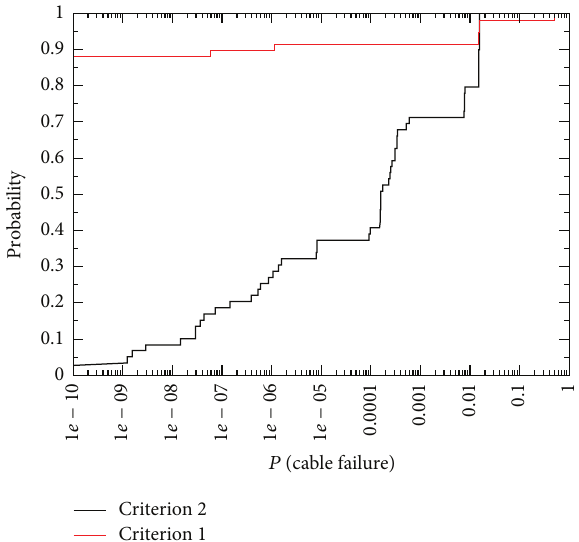
Figure 6: Distribution quantifying the epistemic uncertainty of the probability of I&C cables to be damaged by the